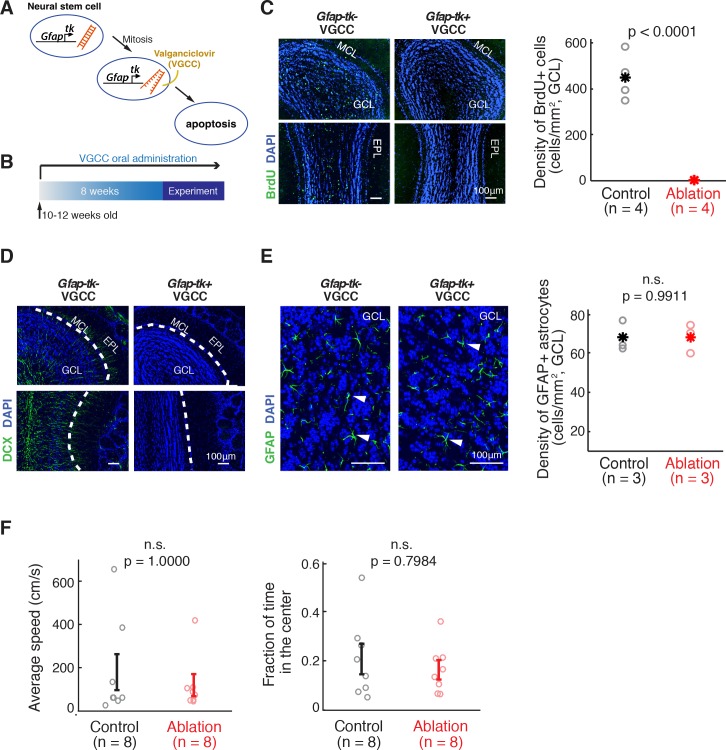
Inducible ablation of adult neurogenesis.(A) Pharmacogenetic ablation of ABNs. Valganciclovir (VGCC) induces apoptosis of Gfap-expressing mitotic neural stems cells, blocking the generation of ABNs. (B) Experimental timeline. Adult mice underwent 8 weeks of VGCC treatment before starting the behavioral task and imaging. (C,D) VGCC administration results in a near-complete ablation of ABNs in the olfactory bulbs of Gfap-tk+ (ablation) mice. (C) BrdU labeling of olfactory bulbs of Gfap-tk- (control) and ablation mice administered with VGCC. Green: BrdU; Blue: DAPI; MCL: mitral cell layer; GCL: granule cell layer; EPL: external plexiform layer. Right: quantification of the BrdU-labeled cell density in control (n = 4, black) and ablation (n = 4, red) (p<0.0001, Wilcoxon rank sum test). Asterisks represent means. (D) Doublecortin (DCX) labeling of immature neurons in the olfactory bulbs showed similar results to BrdU labeling. Green: DCX; Blue: DAPI. (E) VGCC administration in ablation mice does not affect the density of GFAP astrocytes in the olfactory bulb. Left: GFAP immunostaining of astrocytes in the olfactory bulbs of control mice (left panel) and ablation mice (right panel) after 8 weeks of continuous treatment of VGCC. Arrows show examples of GFAP astrocyte cell bodies. Green: GFAP; Blue: DAPI. Right: No significant difference in the density of GFAP astrocytes in VGCC-administered control mice (n = 3, black) and ablation mice (n = 3, red) (mean ±S.E.M.; p=0.9911, Wilcoxon rank sum test). Asterisks represent means. (F) Open field test shows no deficiency in mobility in ablation mice (n = 8, red) compared to controls (n = 8, black). All error bars: mean ±S.E.M. Left: average speed (cm/s) (p=1.0000, Wilcoxon rank sum test). Right: fraction of time spent in the center area (p=0.7984, Wilcoxon rank sum test).